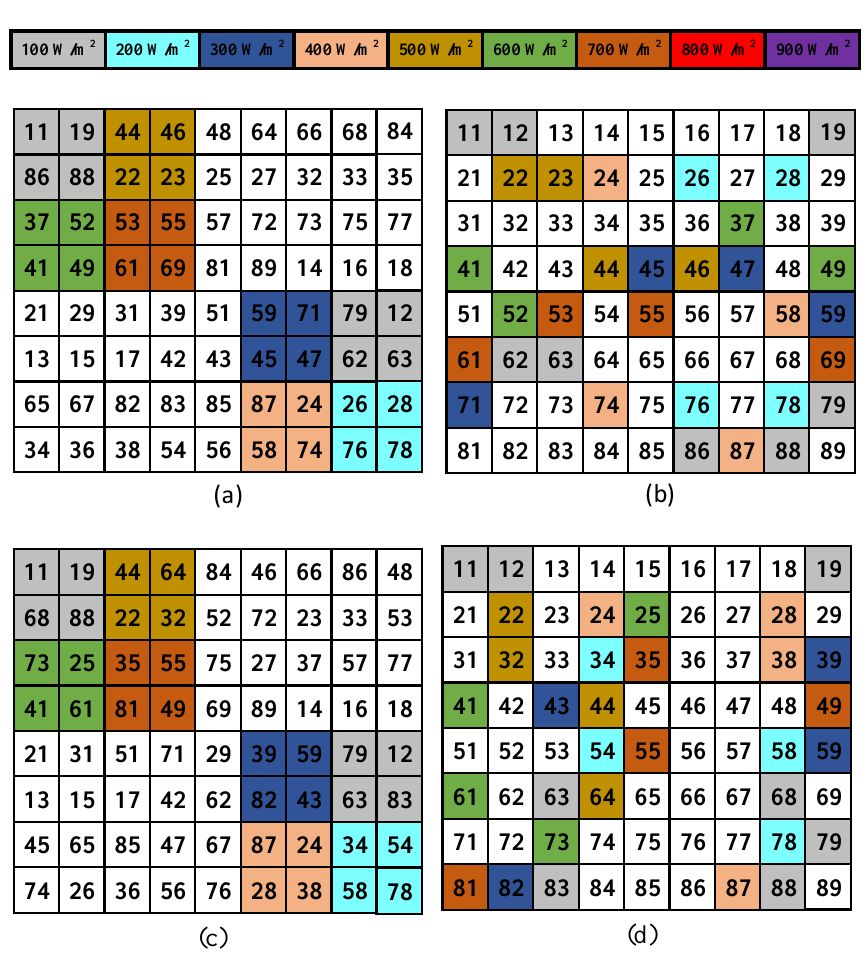
Figure 24. ( a ) OEP; ( b ) shade dispersion of OEP; ( c ) IOEP; and ( d ) shade dispersion of IOEP for 8 × 9 PV array at Top-Left and Bottom-Right PSC.